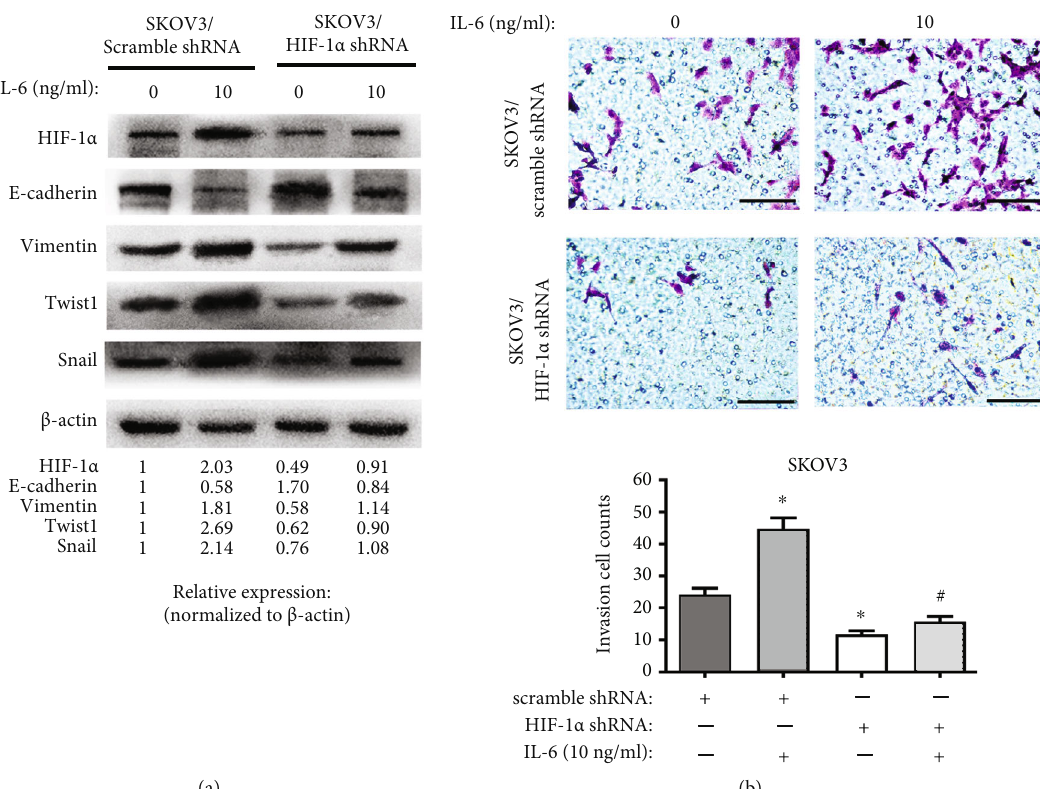
scramble shRNA: HIF-1α shRNA: IL-6 (10 ng/ml):